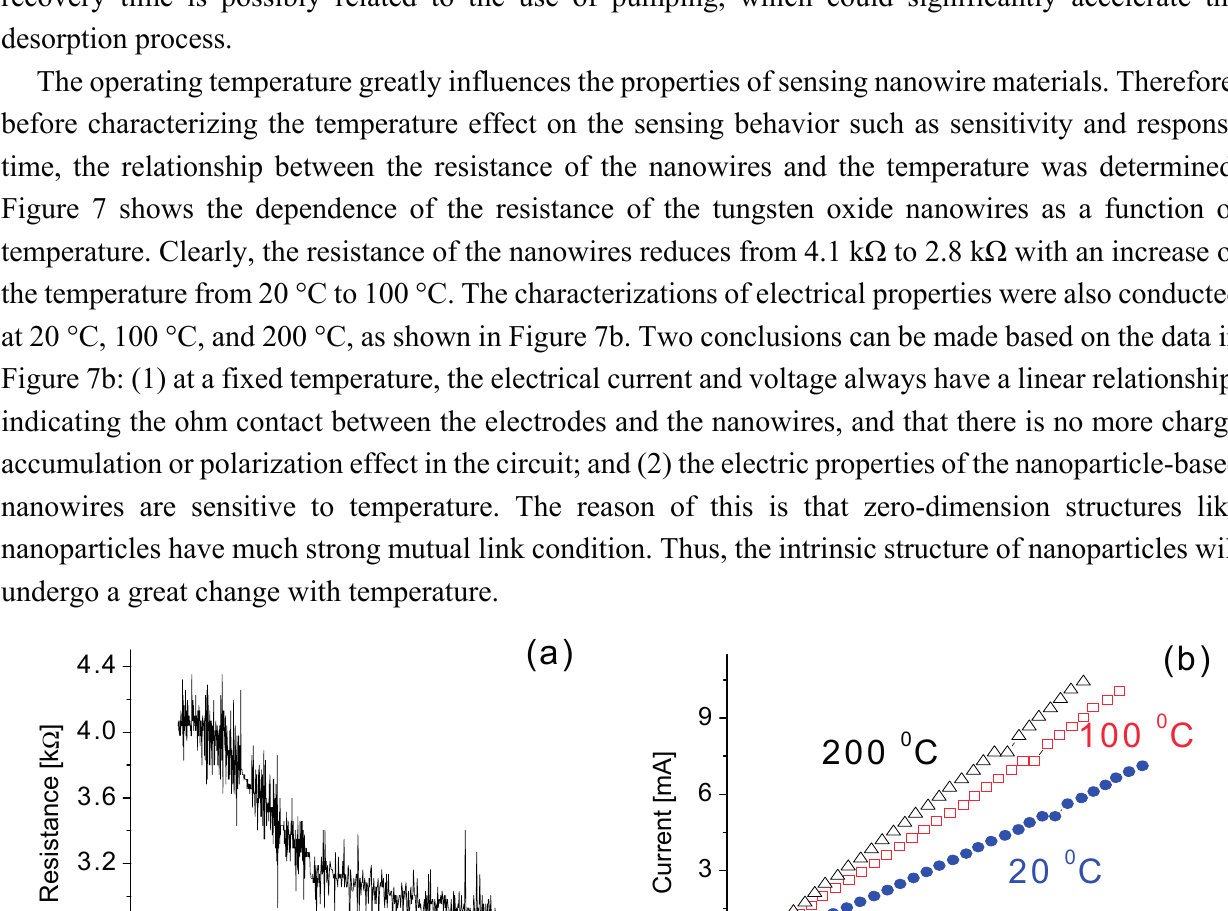
Figure 7. ( a ) Variation of resistance of the nanowires following the increase of temperature; and ( b ) the temperature effect on current-voltage